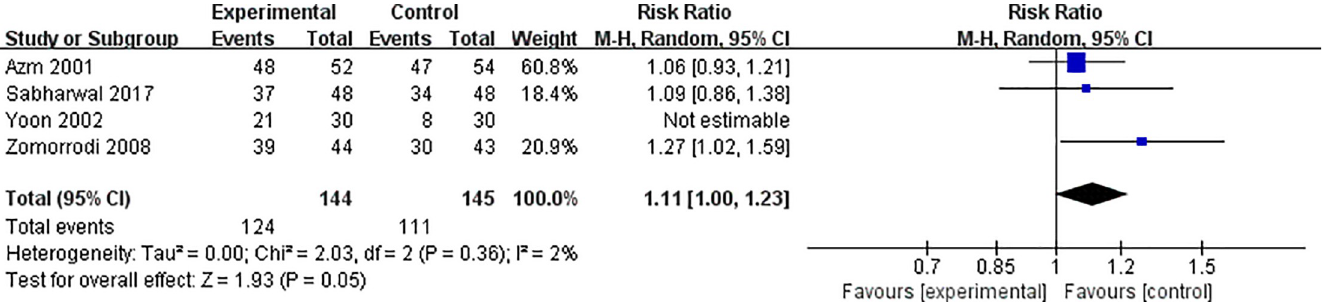
Fig 4. Forest plot for the meta-analysis of stone clearance after sensitivity